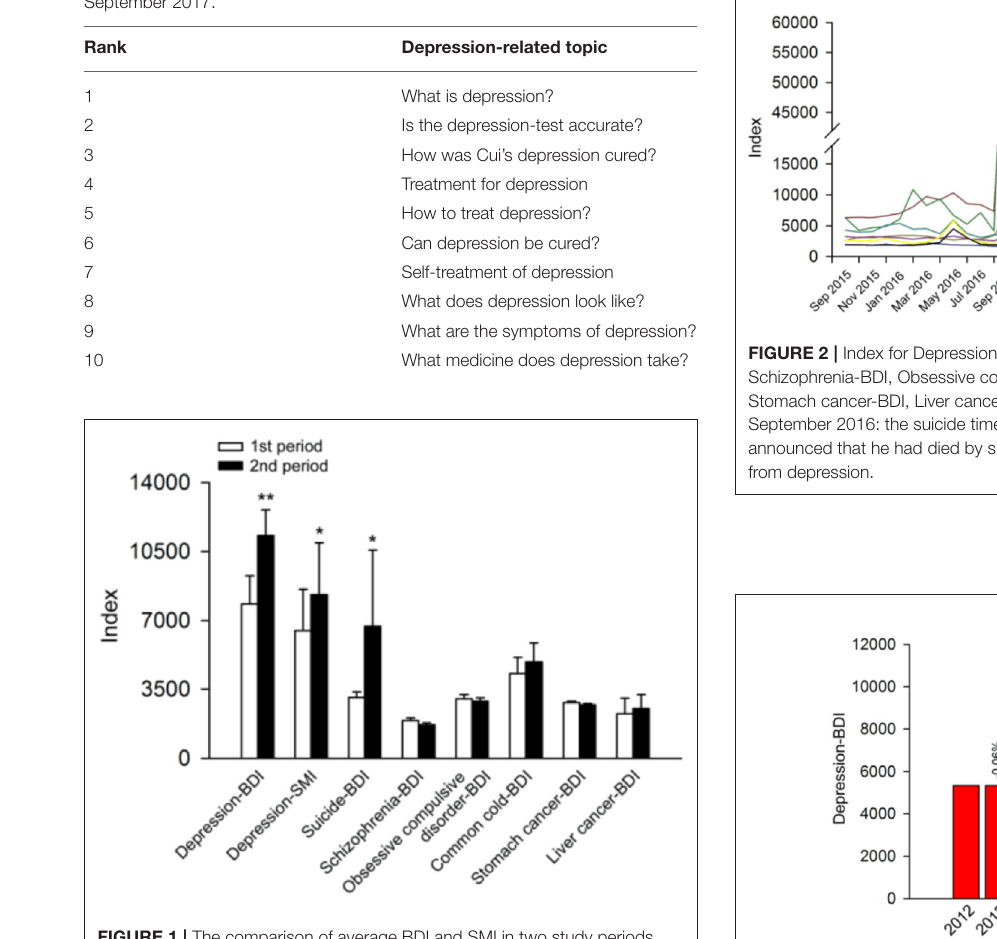
FIGURE 1 | The comparison of average BDI and SMI in two study periods. * p < 0.05, ** p < 0.01. among the three topics.